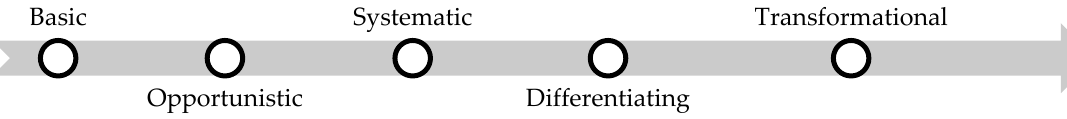
Figure 8. Gartner ’ s Maturity Model for Data and Analytics. Source: own elaboration based on [32].